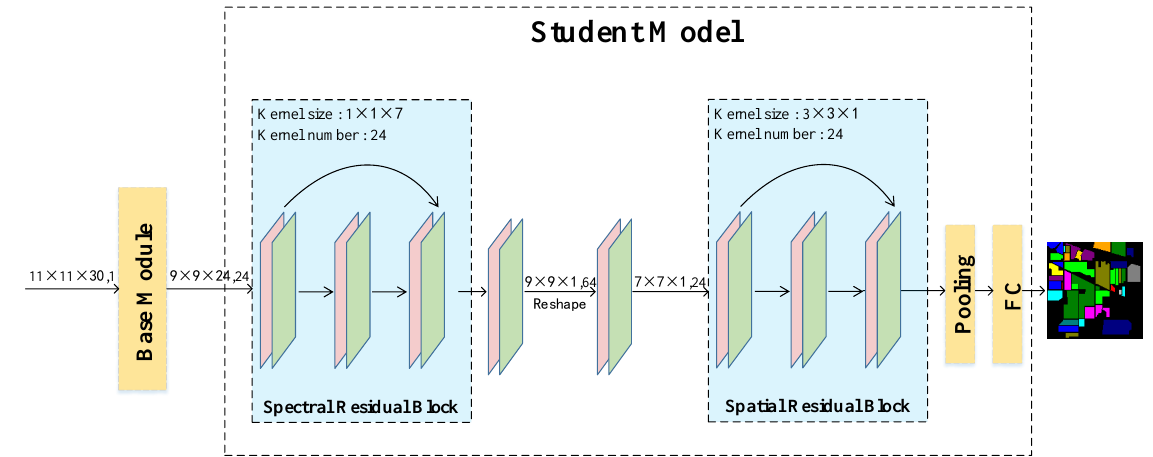
Figure 2. The details structure of the